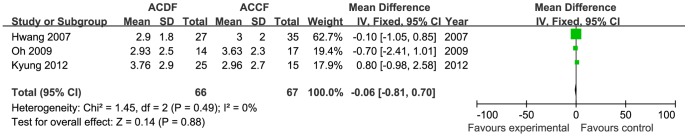
The forest plot for VAS score between ACDF group and ACCF group, CI  =  confidence interval, df  =  degrees of freedom, IV  =  independent variable,SD  =  standard deviation, VAS =  visual analogue score of neck.